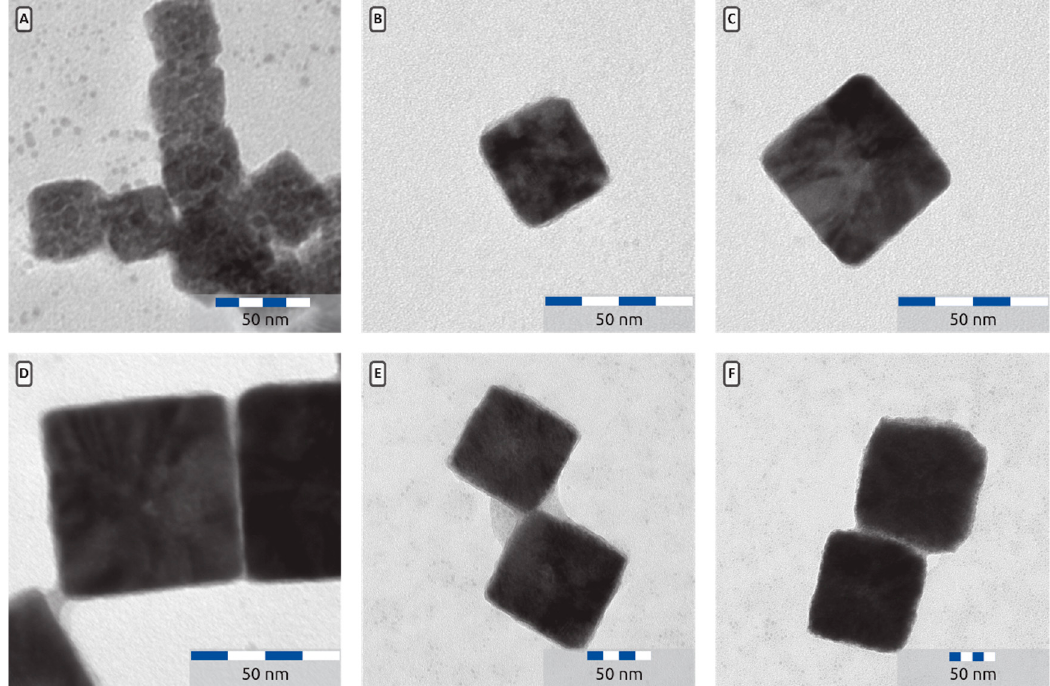
Figure 5. ( A ) Cu 2 O particles prepared with no added water with an edge length a = 41 ± 3 nm. ( B )